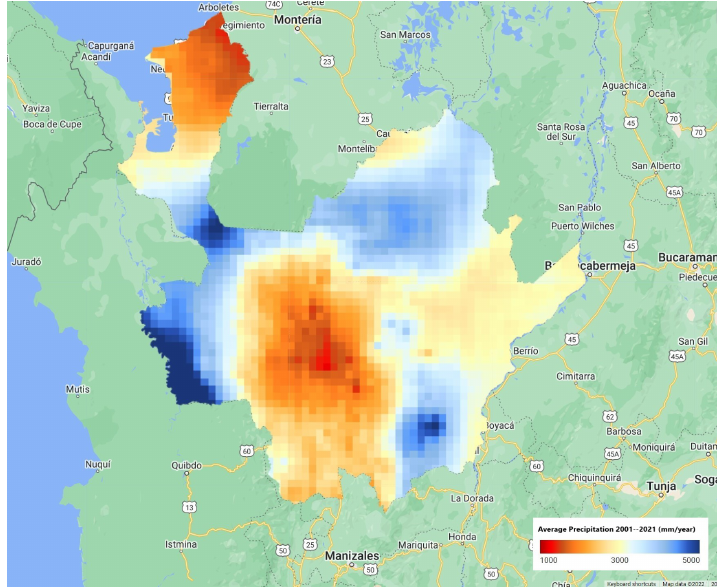
Figure 4. Precipitation values in Antioquia Department, Colombia by the Climate Hazards Group InfraRed Precipitation with Station data